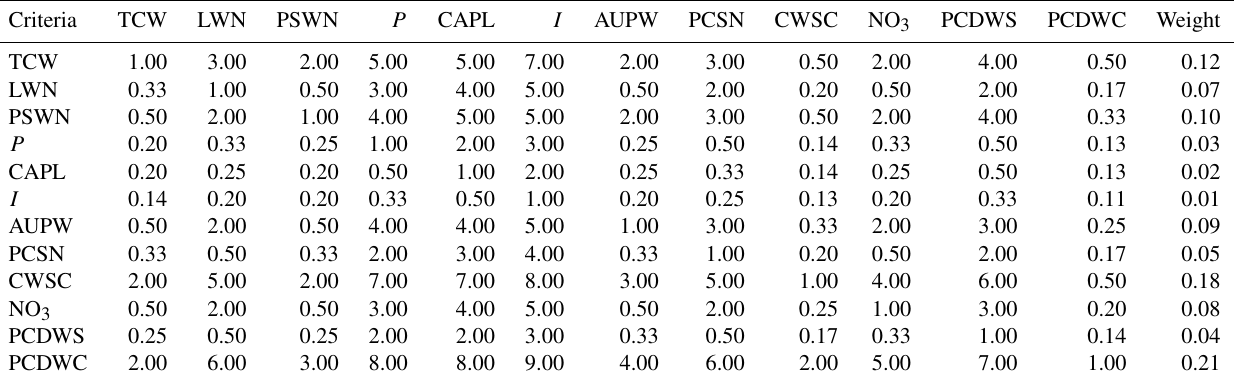
Table 2. AHP pairwise comparison matrix for the domestic water poverty index. Criteria